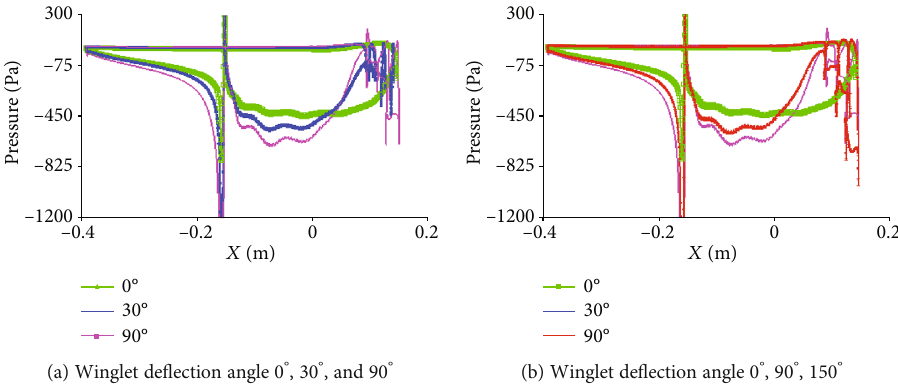
Figure 19: Static pressure distribution curve on the surface of the Fan-wing with single leading edge winglet ( v = 12 m/s, α = 0 °